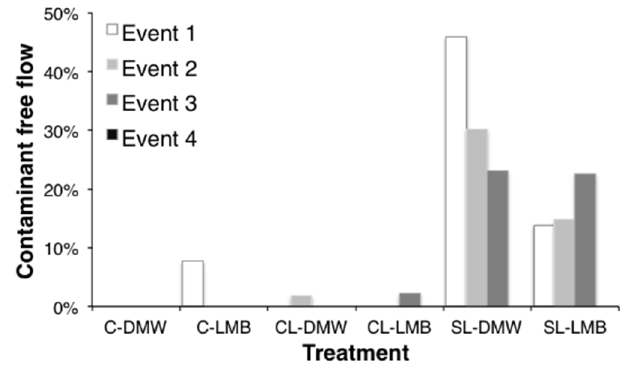
Figure 2. Proportion active collectors not participating in tracer transport ( i.e. , no detectable bacteria or microspheres; i.e. , absolute filtration λ f = ∞ ). C–clay soil; CL–clay loam soil;